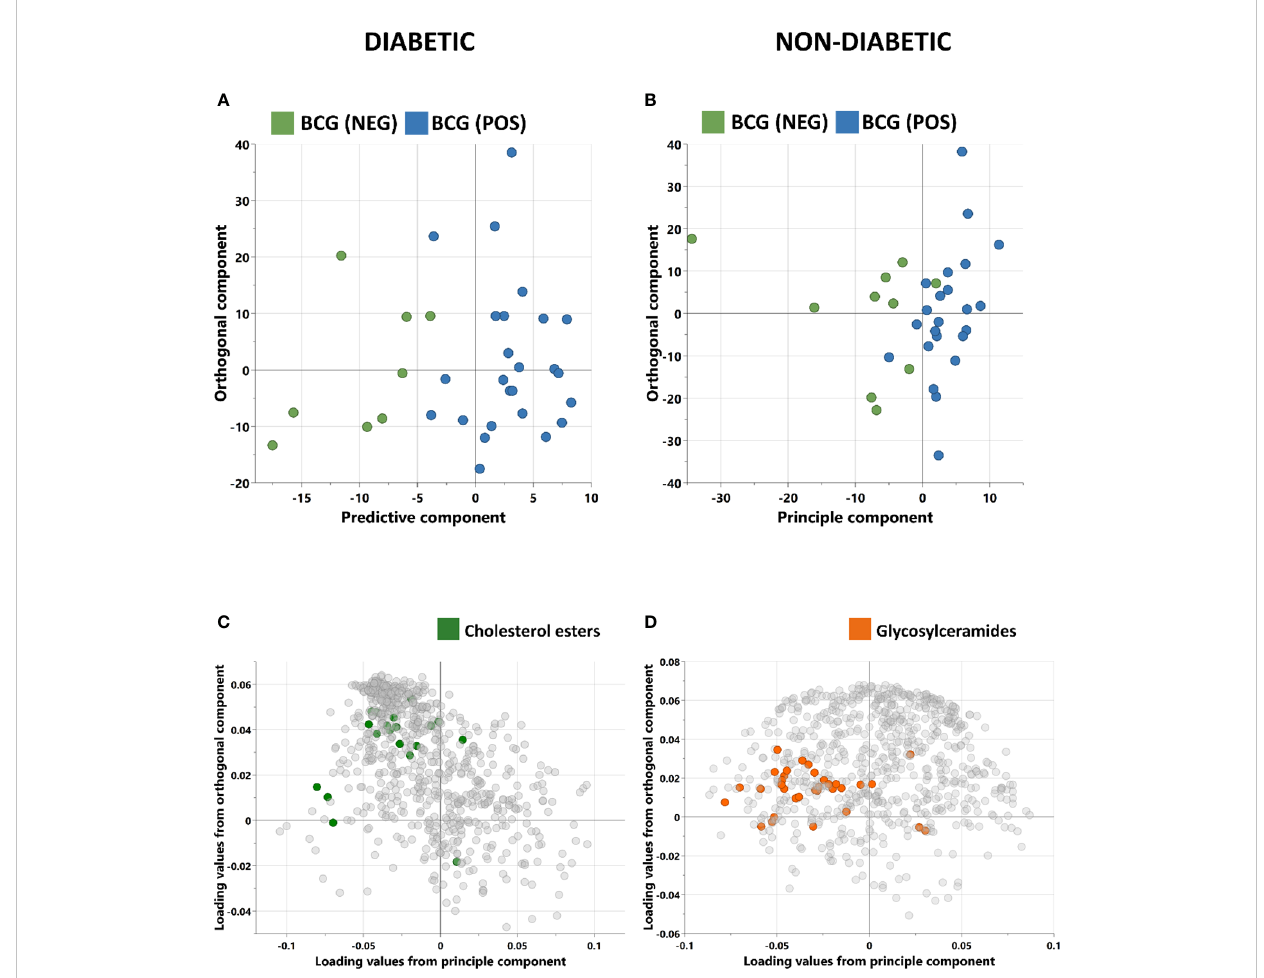
FIGURE 2 Score plots of OPLS-DA models discriminating between BCG vaccinated (BCG-pos) and non-vaccinated (BCG-neg) patients with COVID-19 infection. The analysis was performed separately for (A) Diabetic individuals (B) non-diabetic individuals. OPLS-DA identi fi ed one predictive and one orthogonal component for each model. (C, D) are the respective loading plots for diabetic and non-diabetic COVID-19 patients with highlighted enriched